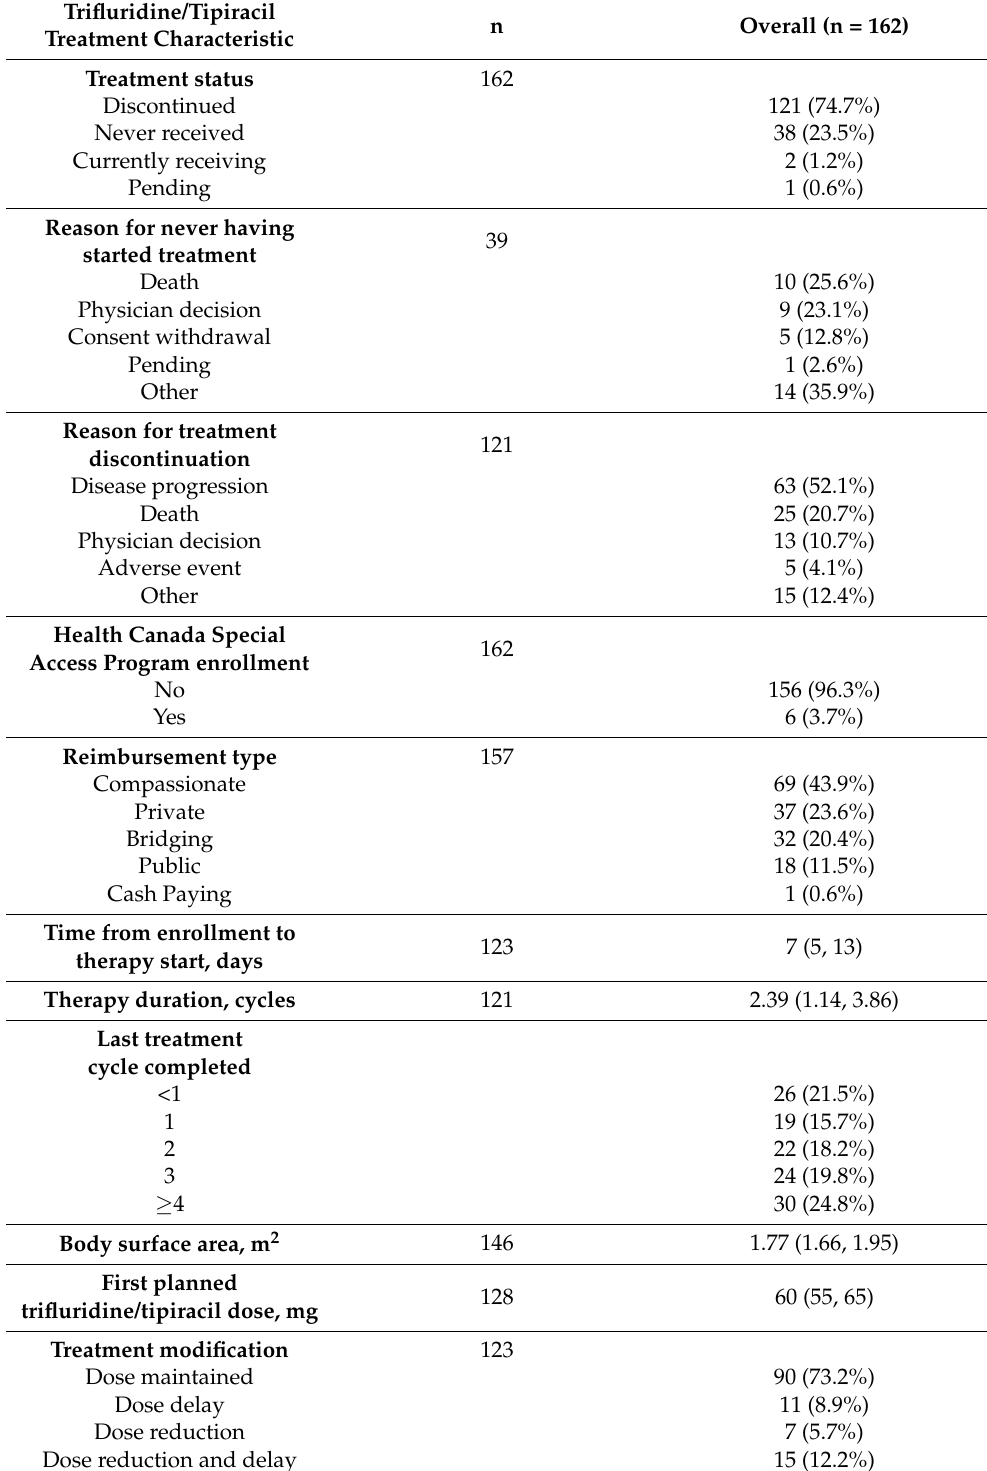
Table 2. Enrollment and treatment characteristics of patients enrolled in Taiho Pharma Canada’s Pa- tient Support Program to receive trifluridine/tipiracil for metastatic gastric/gastroesophageal